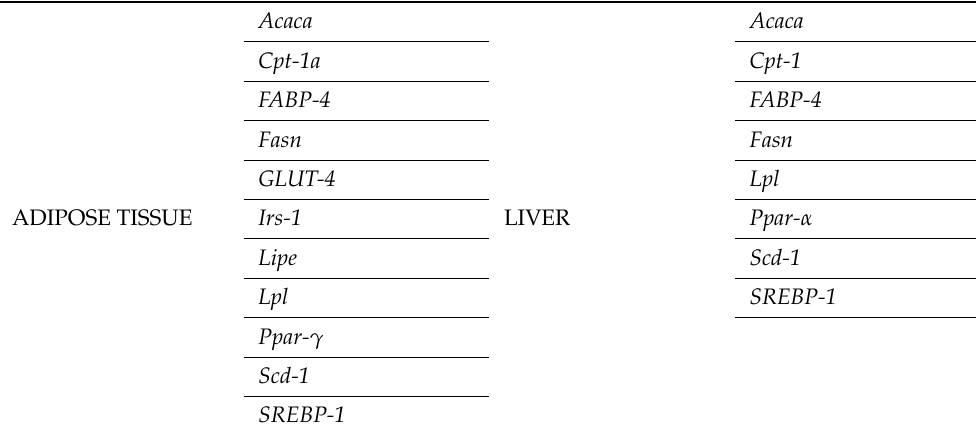
Table 1. mRNA expression of the following genes was analyzed in adipose tissues and in the liver.